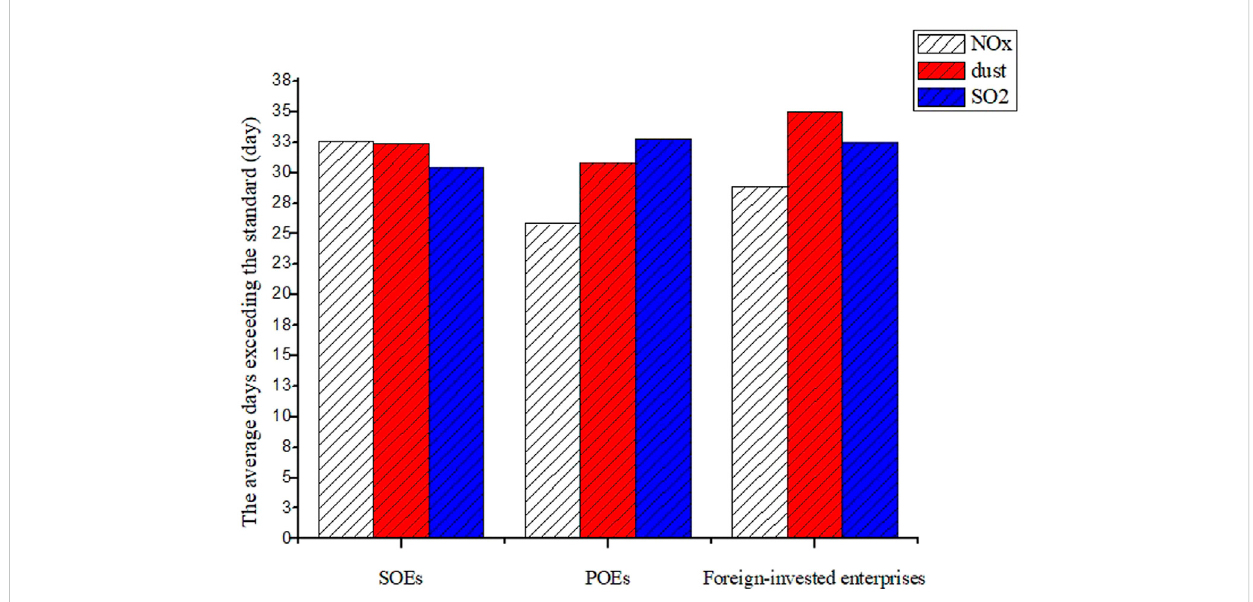
FIGURE 1 The average number of days exceeding the standard emissions in different ownership enterprises in